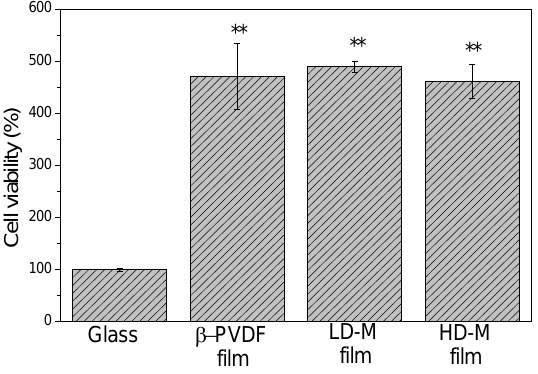
Figure 3. Cell viability for cells seeded on the PVDF samples and on glass covers (positive control) after